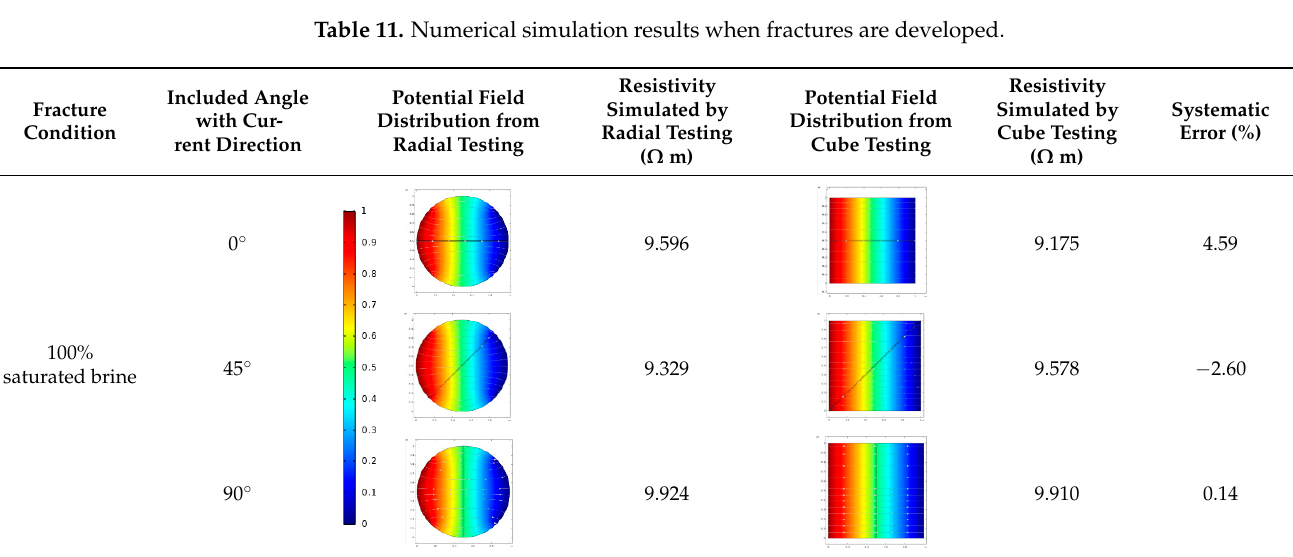
Table 11. Numerical simulation results when fractures are developed.